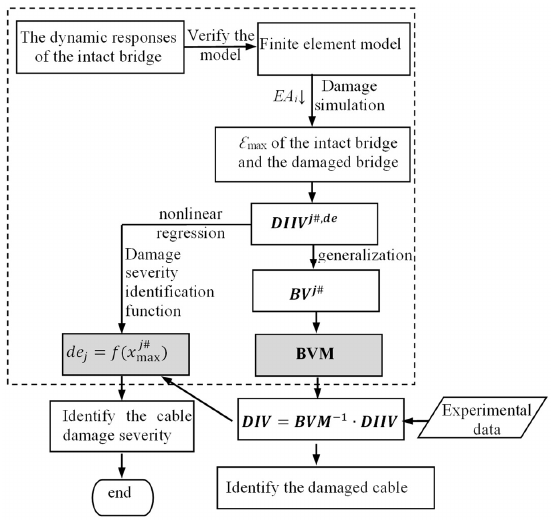
Figure 3. The flow chart of the BVM damaged cable identification procedure.